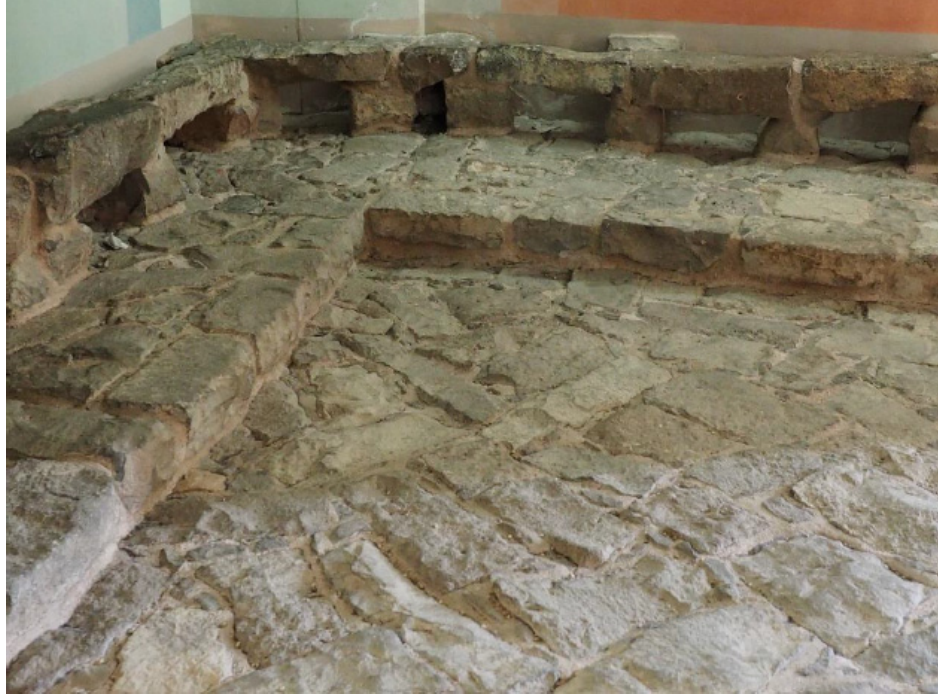
Figure 14. The “grotto” with the mock-antique benches (photo: Assaf Pinkus). To support such an imagined moment of contemplation of the past, the room is dominated by a large hyper-realistic painting behind the altar of the encounter of Christ with the bleeding woman (Figure 15). The painting presents a close-up of several pairs of feet in sandals and the bottom of some simple woven garments. A single hand reaches out to touch what looks like the bottom of a Jewish prayer shawl ( talit ). The outstretched hand, like the feet, is at least a dozen times larger than life-size. The painting keeps the viewer’s gaze at foot-height, a dwarf’s perspective beneath the feet of the giants of a meaningful past. The diagonal angle of the hand, along with a ring of light at its point of contact with the fabric, suggests an electric dynamism—a magical and transient moment. One can almost imagine the feet moving forward, the sharp light diminished and the hand drawn back, transformed by the magical moment of contact with the divine. The focus on the contemporary image is highlighted by the stark simplicity of the empty room, whose architectural details (paving and mock-antique benches) speak to other